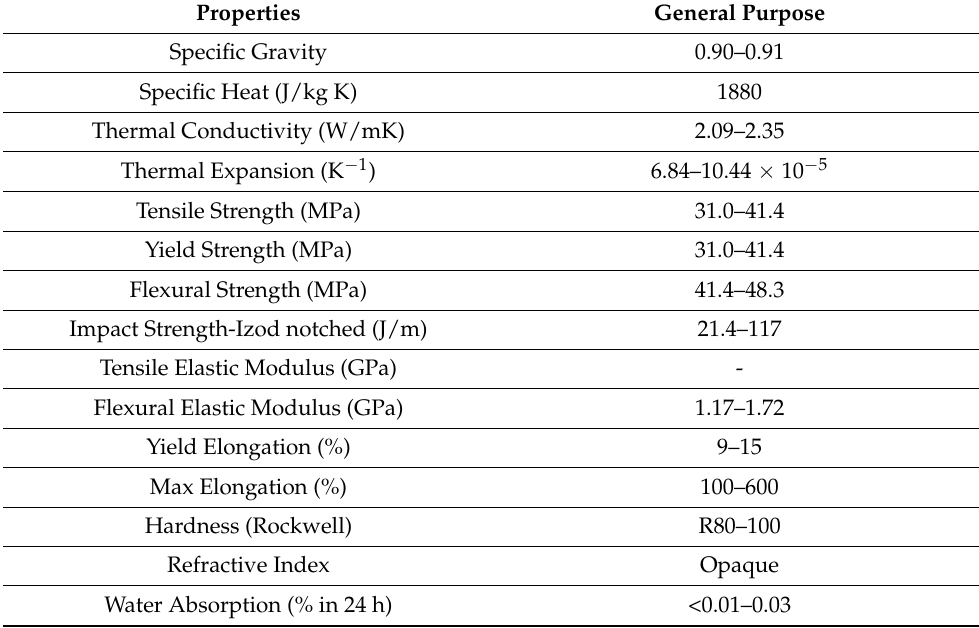
Table 5. General properties of Polypropylene